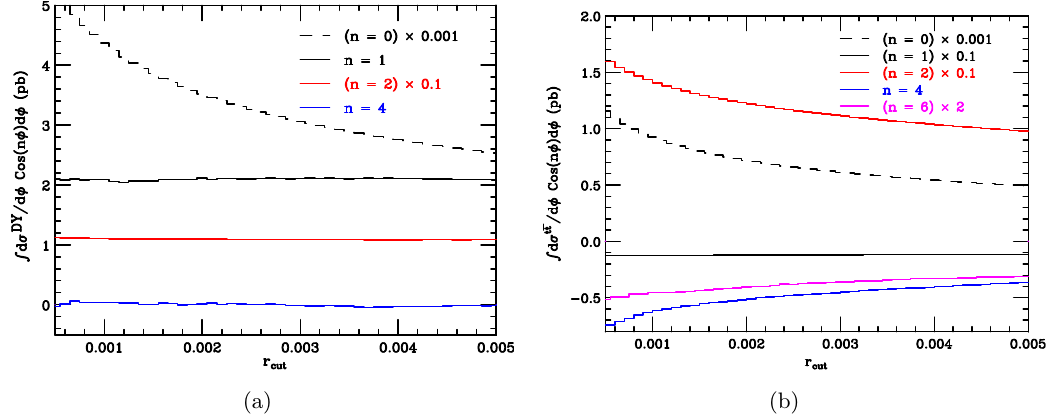
Figure 1 . Lowest-order harmonics as a function of r cut = q cut =M in the cases of DY lepton pair (left) and t (cid:22) t (right) production at the